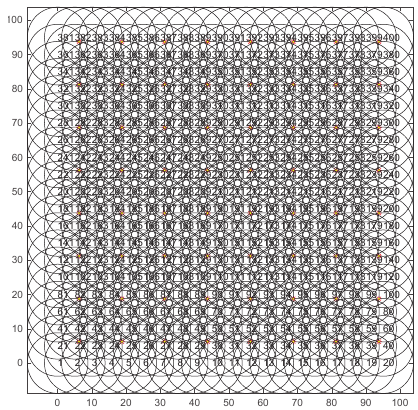
Figure 6. Distribution of 400 nuiform nodes and 64 monitoring target